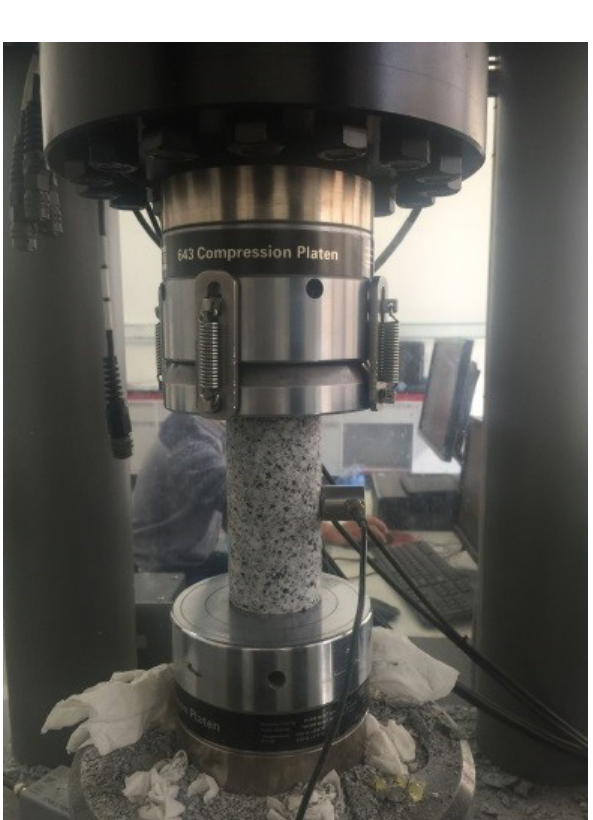
Figure 1: MTS816 servo-controlled rock mechanics experimental